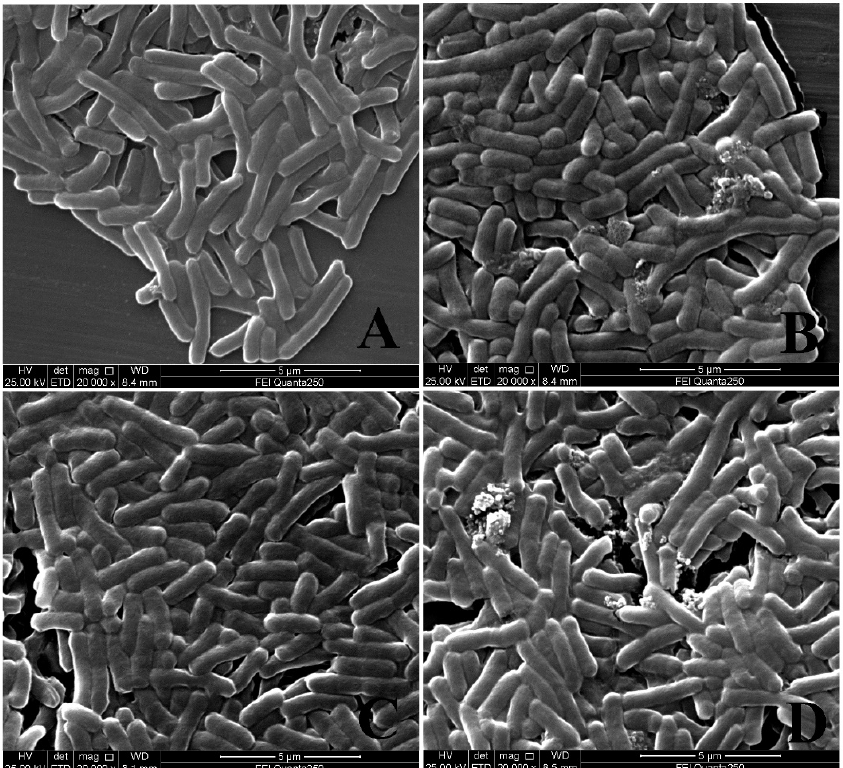
Figure 2. Morphological changes of E. coli treated with pBD2, viewed by scanning electron microscopy. ( A , B ) indicate the E. coli treated with 0 and 20 µ g/mL pBD2 for 1 h, respectively; ( C , D ) indicated the E. coli treated with 0 and 20 µ g/mL pBD2 for 4 h, respectively. Table 1. Sequencing data statistics.